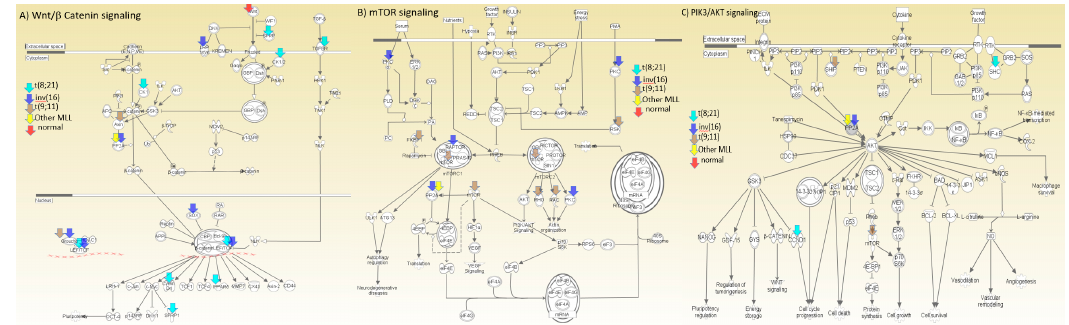
Figure 5. Representation of selected pathways ( A ) Wnt/b-catenin, ( B ) mTOR, and ( C ) PIK3 signaling pathways representing genes identified within different cytogenetic groups. Arrow color corresponds to the respective cytogenetic feature.